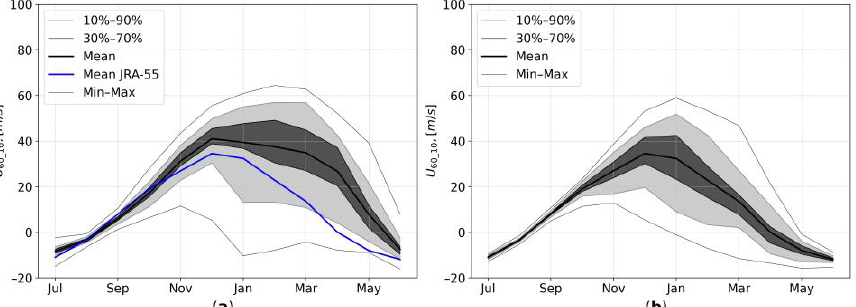
Figure 1. Long-term averaged monthly mean values of the intensity of the stratospheric polar vortex (SPV), zonal mean zonal wind along 60 ◦ N at 10 hPa [m/s] and its 10th, 30th, 70th, and 90th percentiles, according to the control experiment ( a ) and JRA-55 reanalysis data ( b ). The data for the control experiment are provided for 100 years, and the JRA-55 reanalysis data for the period [1958/59–2020/21].